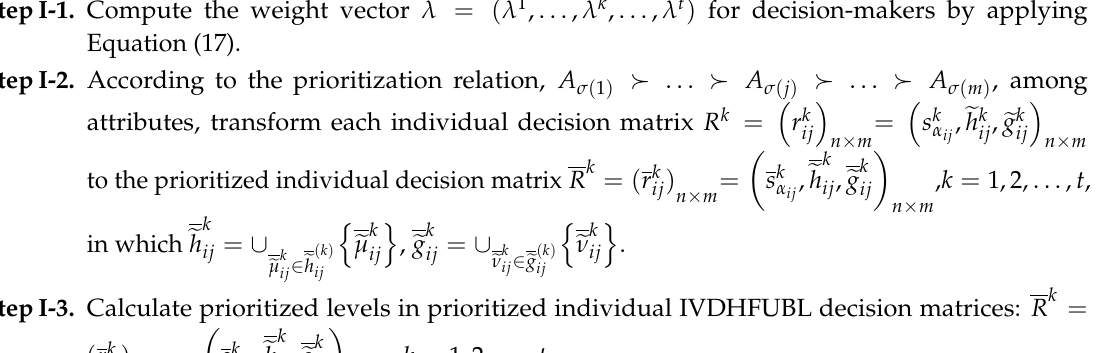
Procedure I. MAGDM based on IVDHFUBLS with prioritization relation among evaluative attributes and unknown decision-makers’